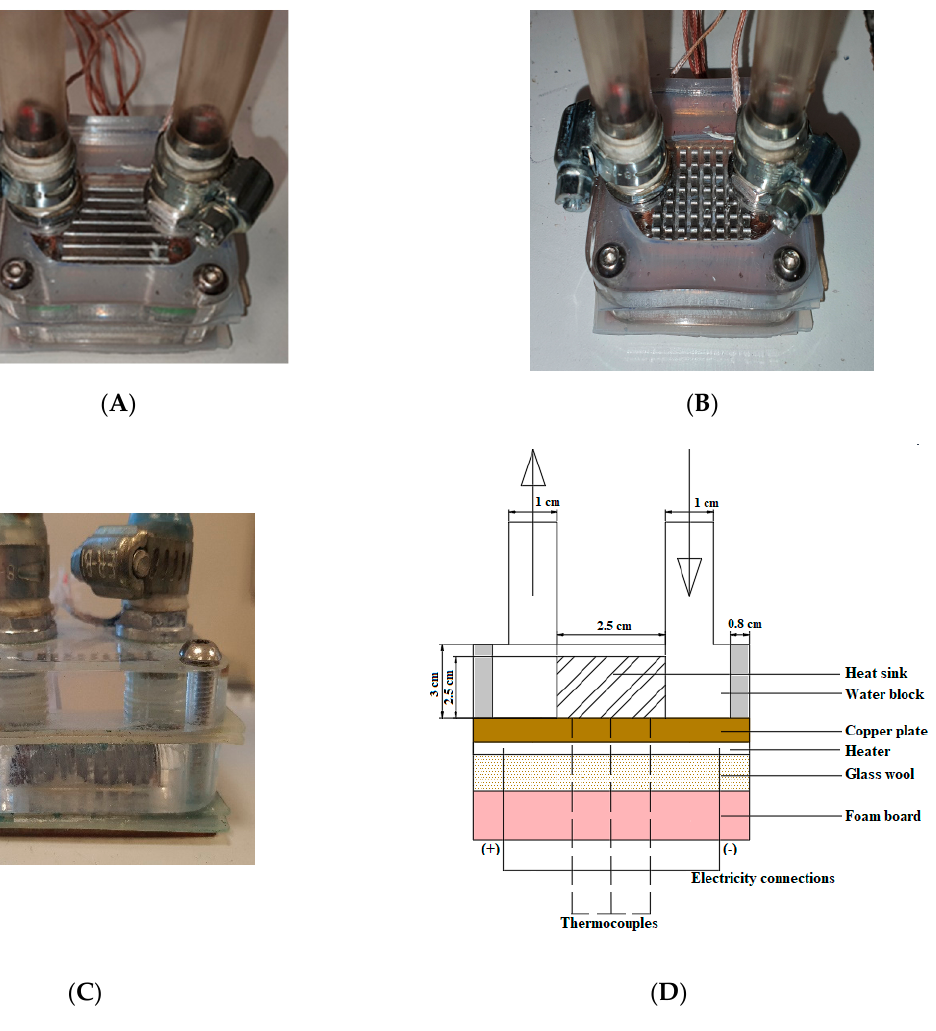
Figure 3. Test section; ( A ) Plate fin heat sink placed water block; ( B ) Pin fin heat sink placed water; ( C ) Side view of the water block; ( D ) Schematic drawing of heating assembly.